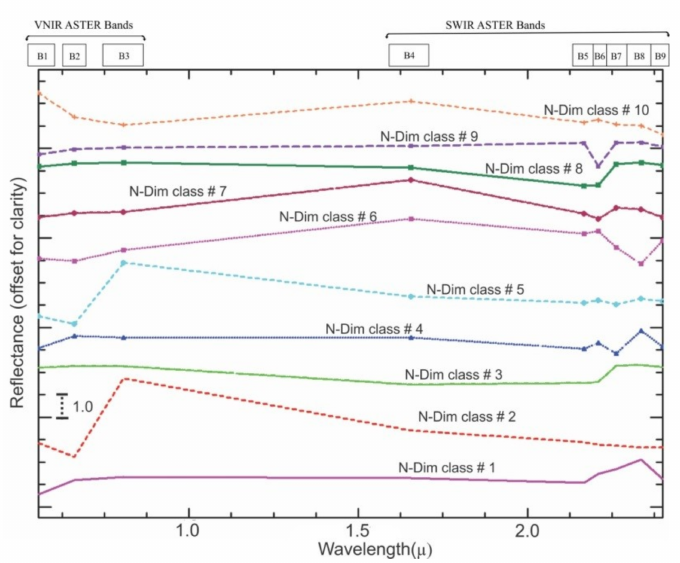
Figure 2. The endmember mineral extracted from the ASTER dataset using of n-Dimensional visualization method. The reference spectra were resampled to the response function of ASTER bands. The ASTER band center positions are also